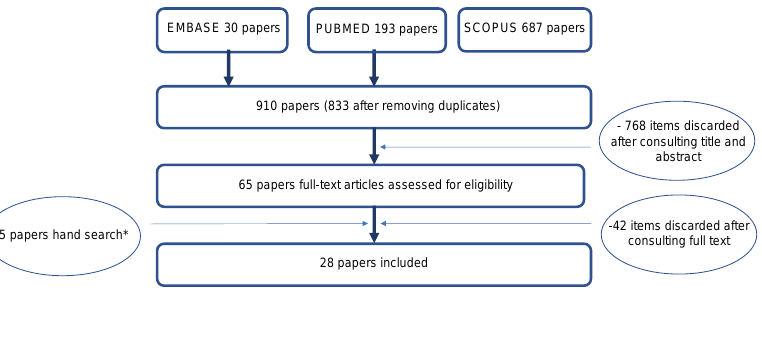
Figure 1. Flowchart of the literature search and selection process. The references were retrieved from the databases of Embase, MEDLINE/PubMed and Scopus.